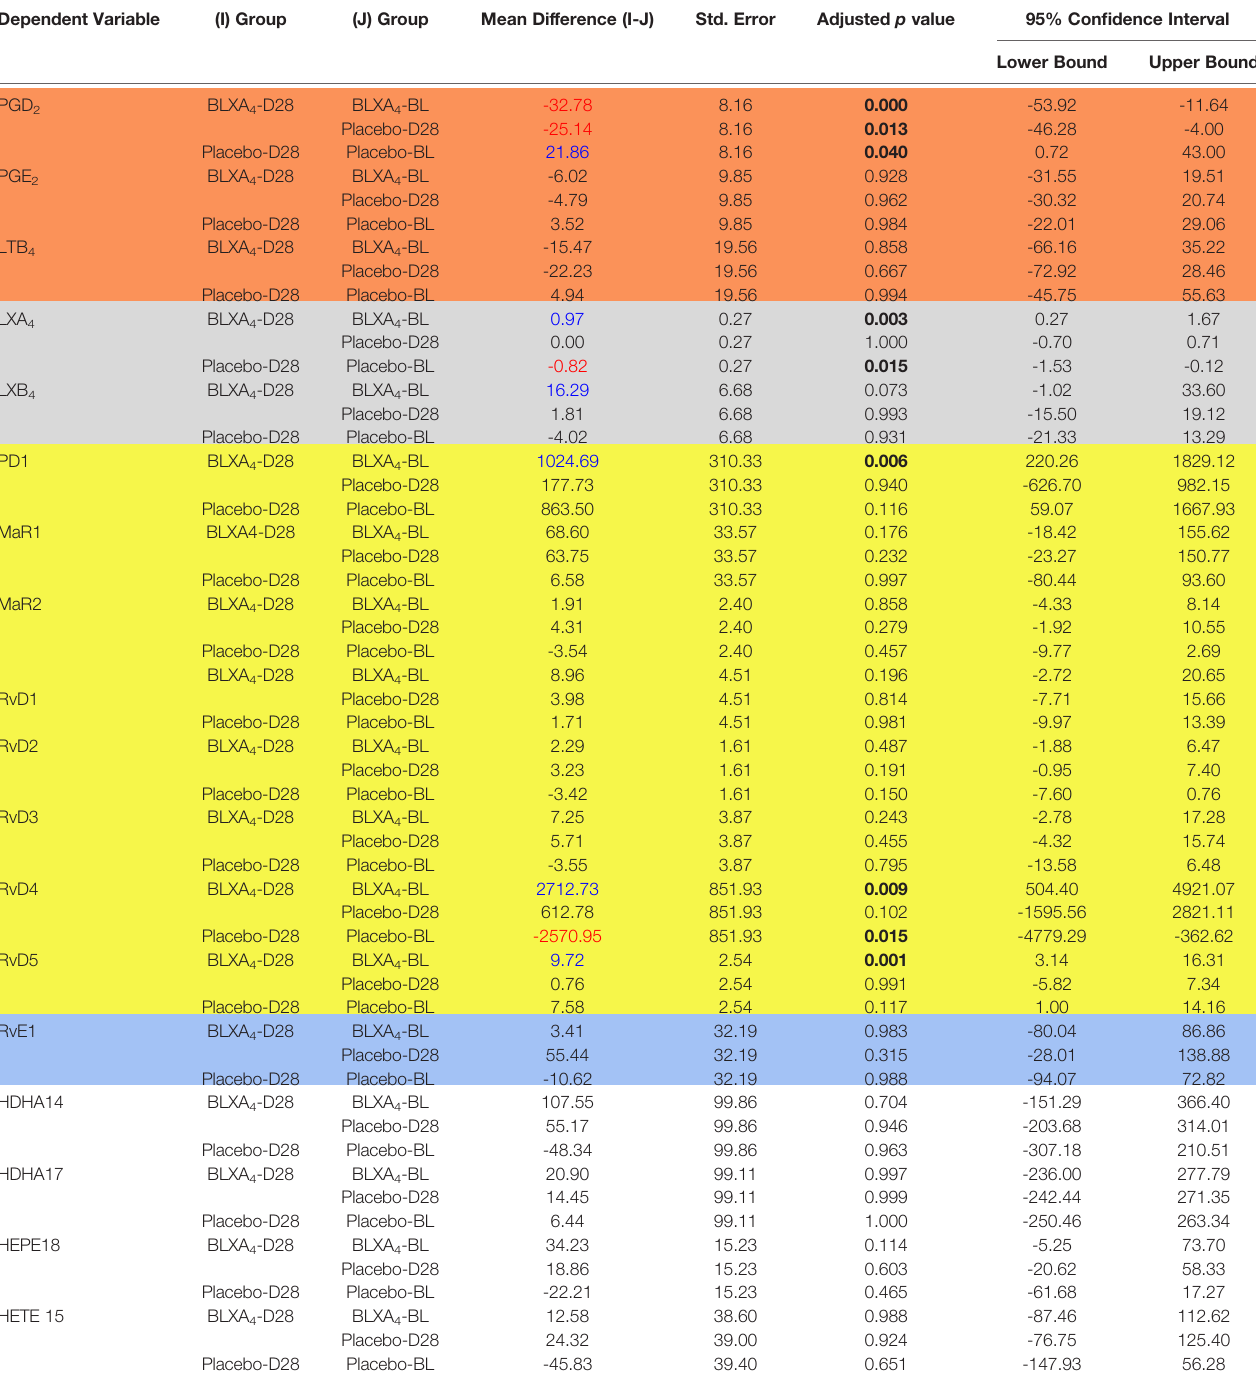
TABLE 4 | Changes (Mean ± SE with 95% con fi dence intervals) at Day 28 from baseline (within group and between group comparisons for BLXA 4 and placebo rinse groups). Dependent